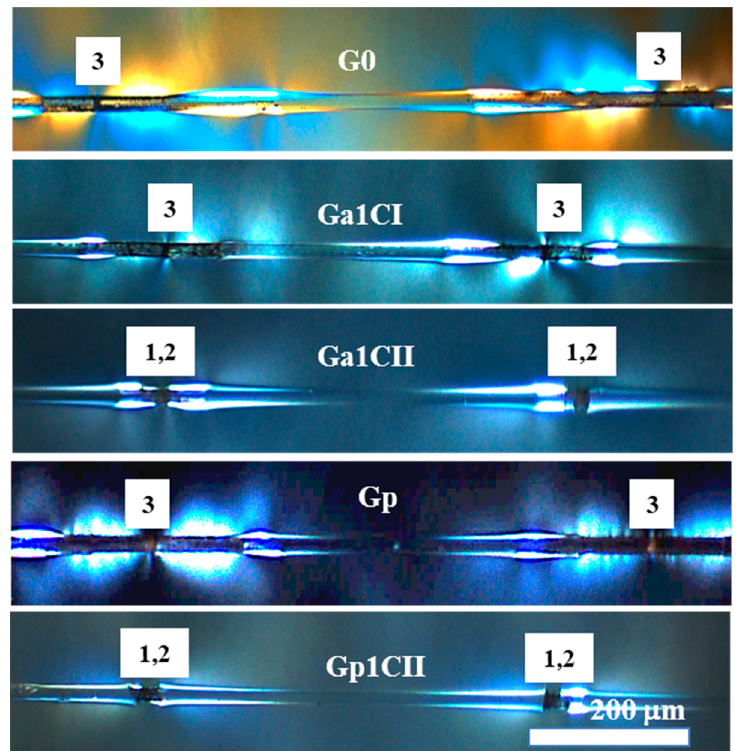
Figure 7. The photoelastic effects of the SFFT for aqueous-based coating formulation samples: G0, Ga1CI, Ga1CII, Gp, and Gp1CII coating formulations.